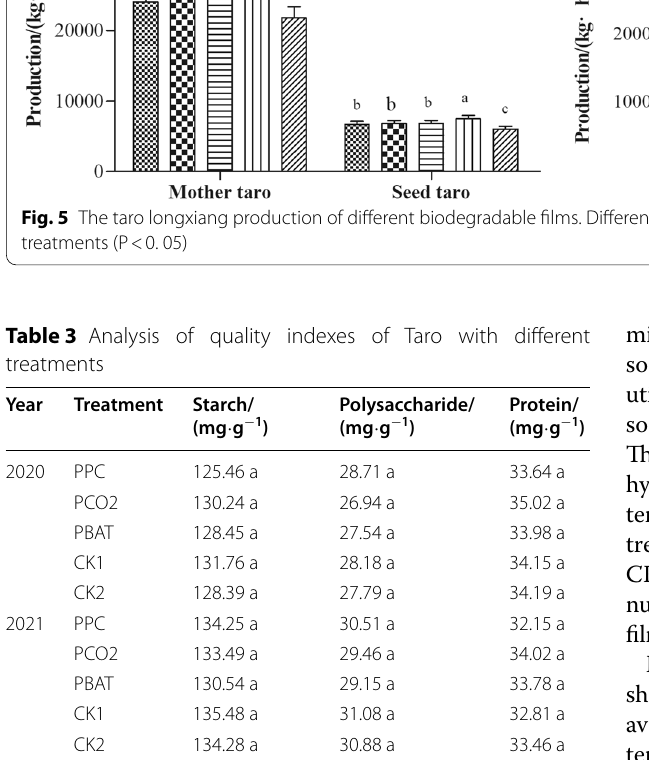
Different lower-case letters denote significant differences among treatments